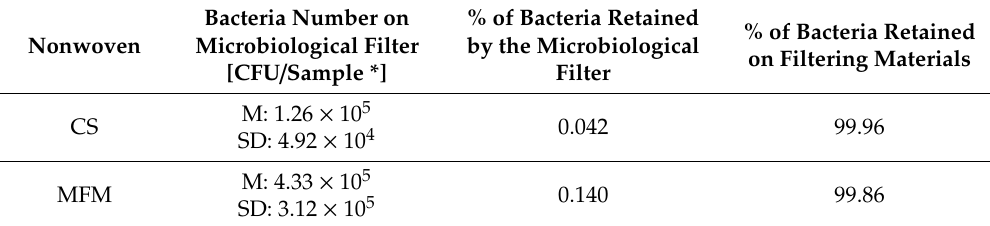
Table 2. CS and MFM filtration e ffi ciency against S. aureus bacteria. % of Bacteria Retained Bacteria Number on by the Microbiological Nonwoven Microbiological Filter [CFU / Sample *]